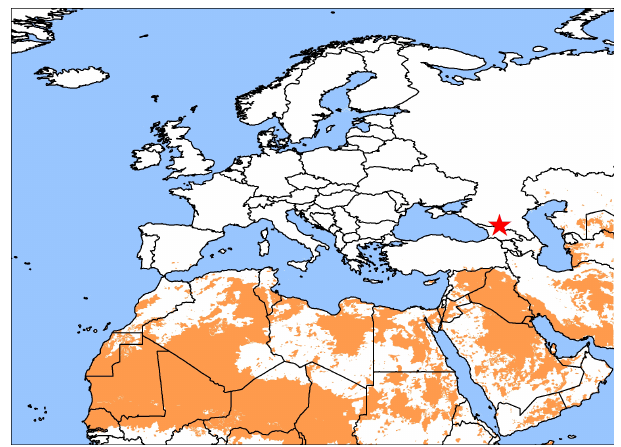
Figure 1. Map showing the location of the Elbrus site (red star) and dust sources (orange shading, based on Kutuzov et al., 2019, and references therein).